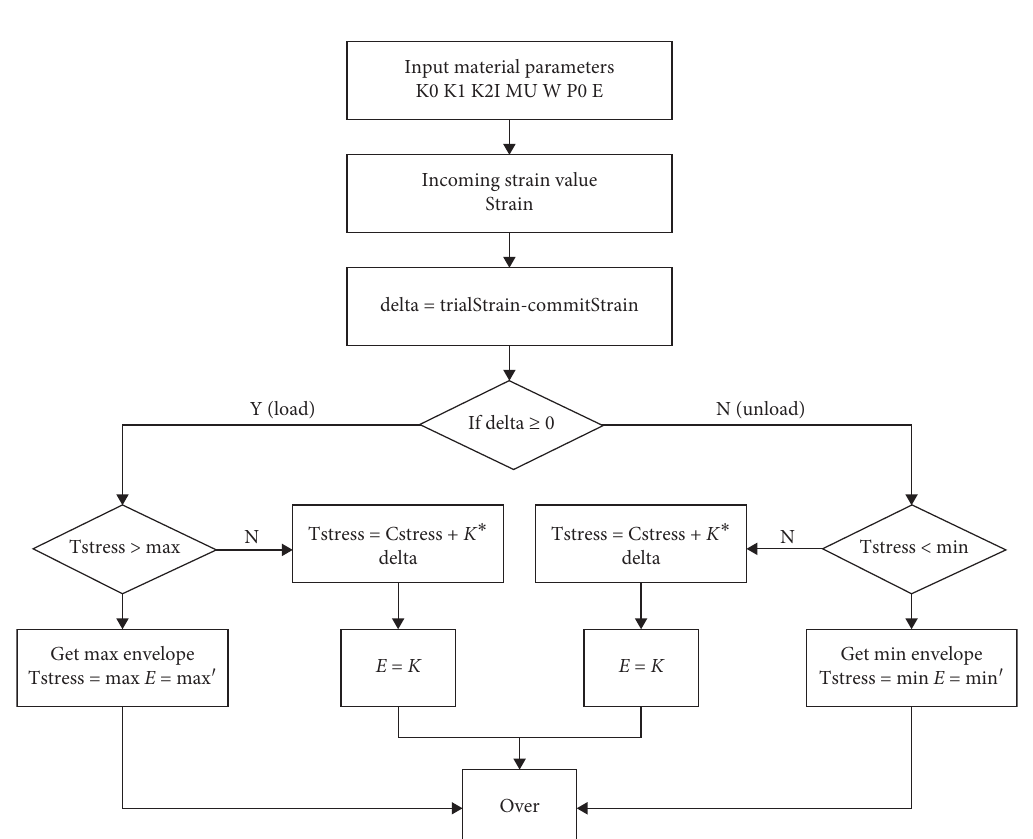
Figure 11: The flow chart of numerical SCVF